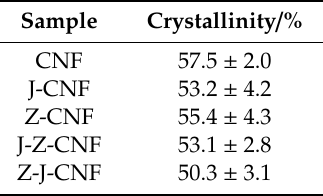
Table 2. Crystallinity index ( Cr I ) of CNF and modified CNF.